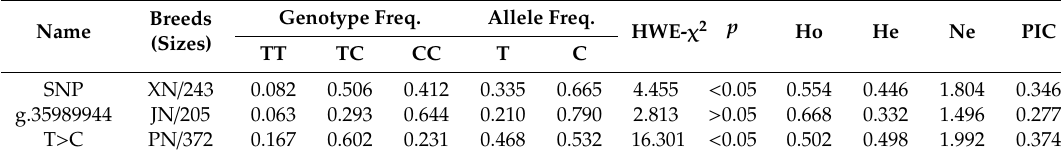
Table 3. Population genetic indices of the SNP mutation.